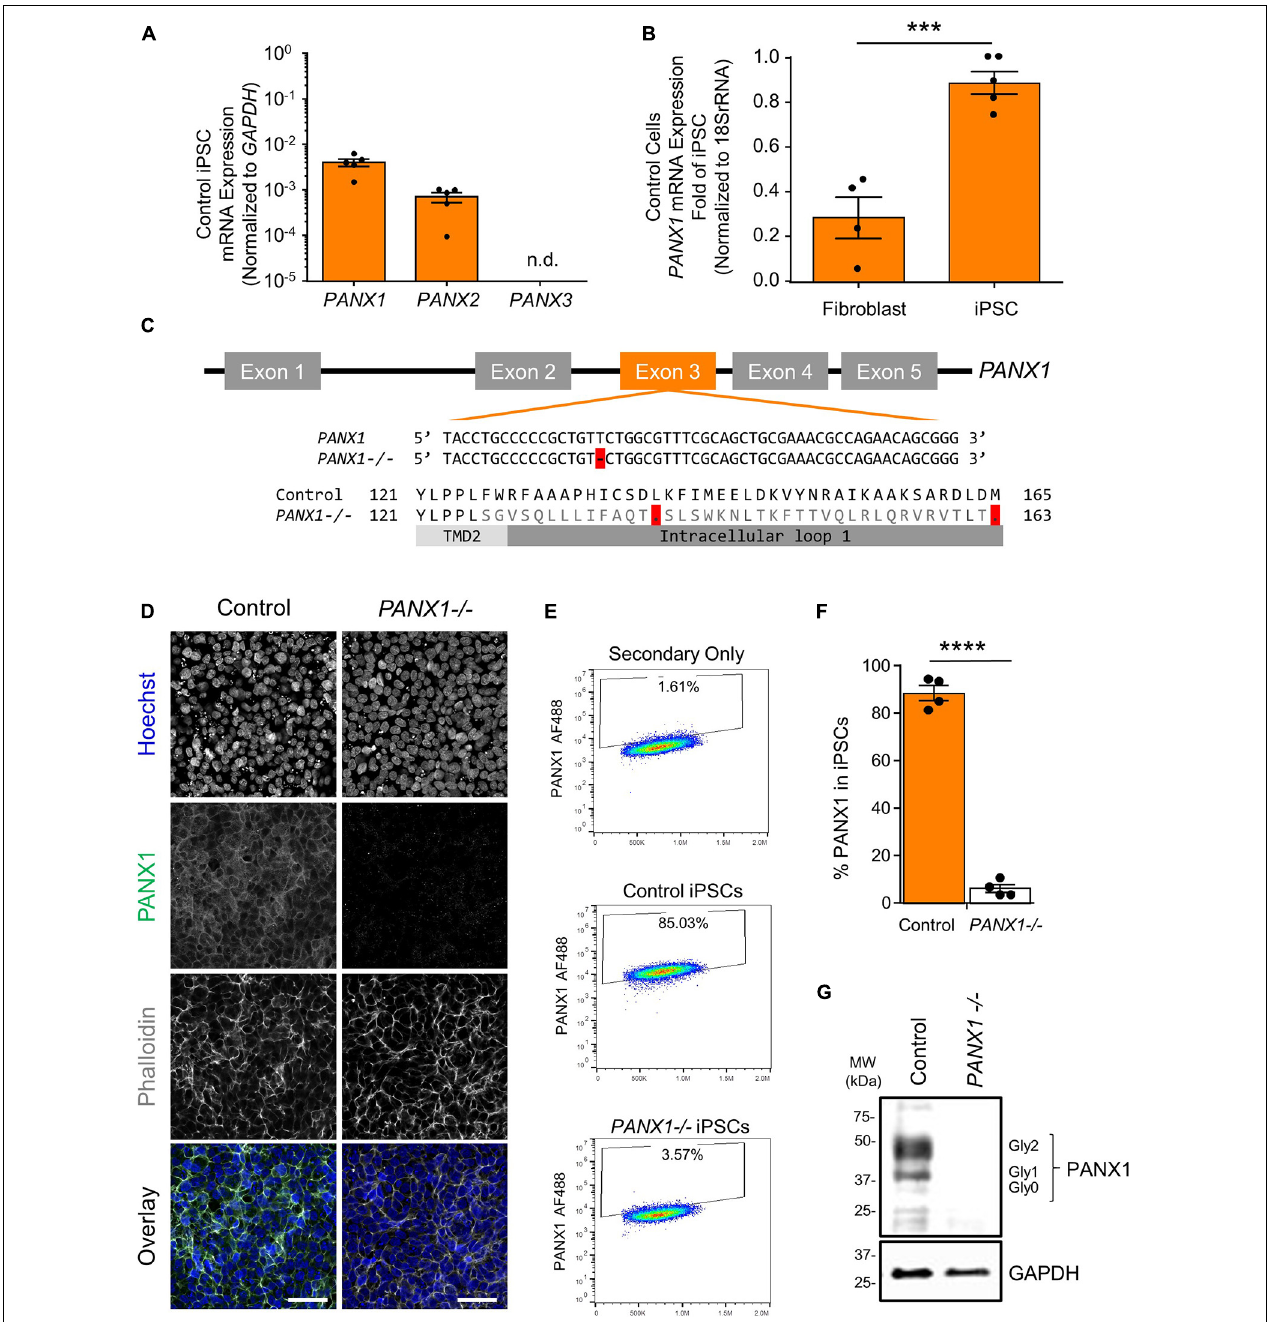
FIGURE 1 | PANX1 expression and CRISPR-Cas9 gene ablation in human iPSCs. (A) Quantitative RT-PCR (qPCR) demonstrates the presence of PANX1 and PANX2 transcripts in human iPSCs, but not PANX3 . n.d. qPCR non-detect. (B) PANX1 mRNA is significantly upregulated in human iPSCs compared to the dermal fibroblasts from which they were derived. Data represent the standard error of the mean of 5 independent experiments. ***, p < 0.001 as assessed through Student’s T -test. (C) CRISPR-Cas9 guide RNA was designed targeting the third exon of the human PANX1 gene. Resulting CRISPR-Cas9 engineering induced a single base pair deletion, thus disrupting the reading frame. After gene ablation, human iPSCs no longer express PANX1 protein as shown through immunofluorescence (D) , flow cytometry (E,F) , and Western blot (G) . In the Western blot, control human iPSCs express PANX1 protein as several discreet band sizes corresponding with the non-glycosylated protein (Gly0), high mannose (Gly1) and complex carbohydrate addition (Gly2). Immunofluorescence images were acquired using consistent parameters and are representative of more than 5 replicate experiments. Equal adjustments for brightness or contrast in FIJI were applied to both conditions. PANX1 (green); Nuclei (Hoechst, blue); Actin (Phalloidin, gray). Data represent the standard error of the mean of 4 independent experiments. ****, p < 0.0001. Scale bar = 50 um.